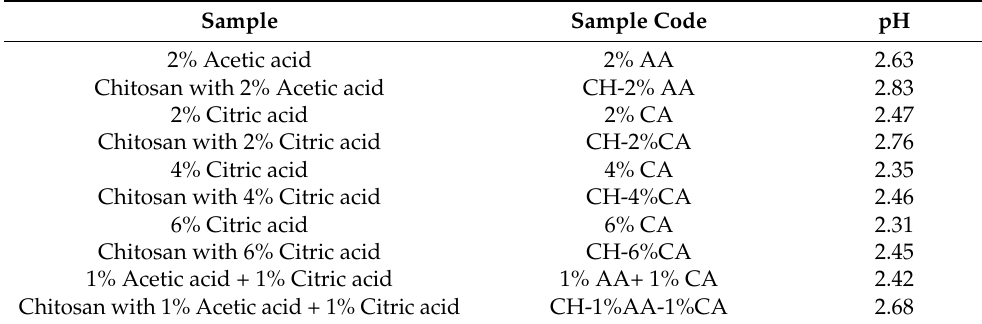
Table 1. The pH of the chitosan solution along with